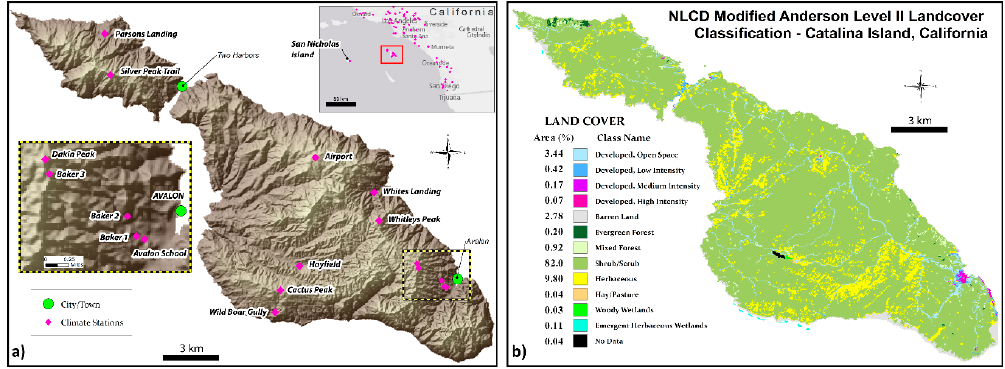
Figure 1. Catalina Island topography and locations of climate stations ( a ) and modified Anderson Level II land cover classification ( b ).